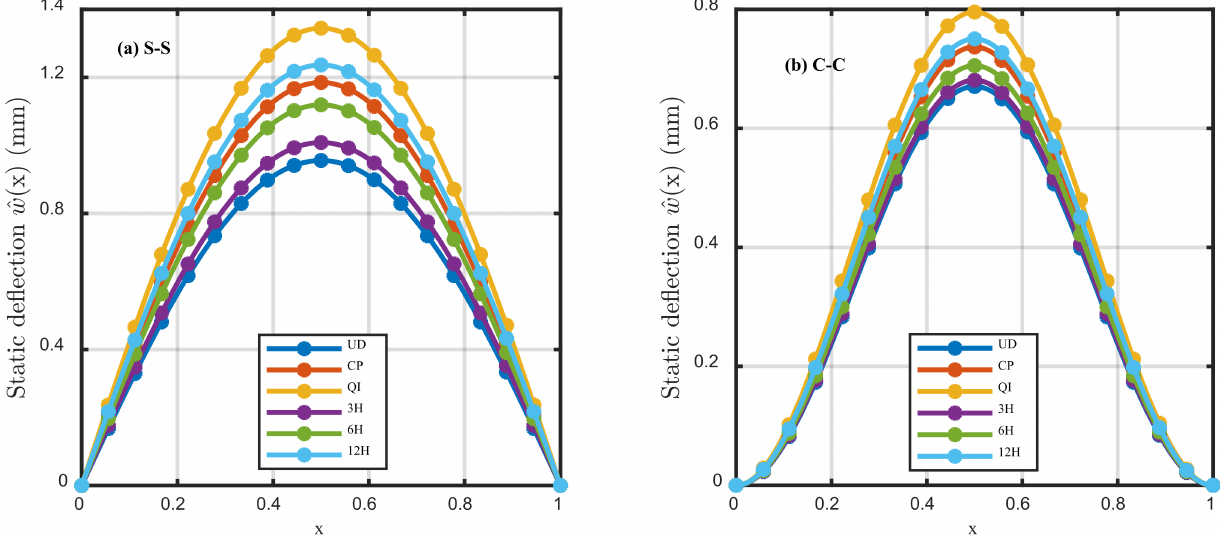
Figure 4. The nonlinear bending deflection of imperfect S–S and C–C composite beams subjected to uniform load with different layup sequences ( L = 100 h , k s = k L = 0, A 0 = 0.5, ˆ q 0 = 5 N / m )